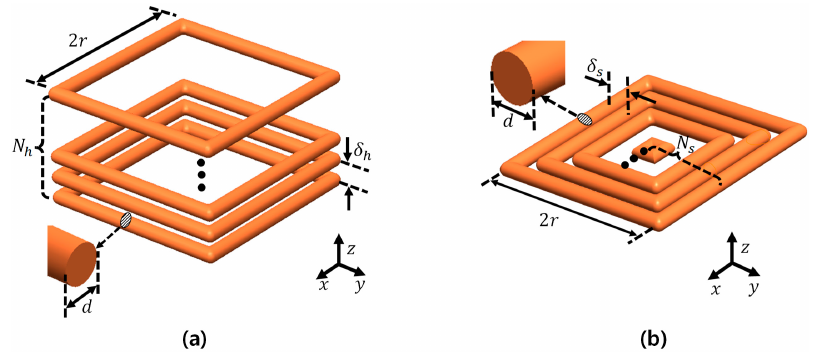
, respectively, as described in Figure 3.